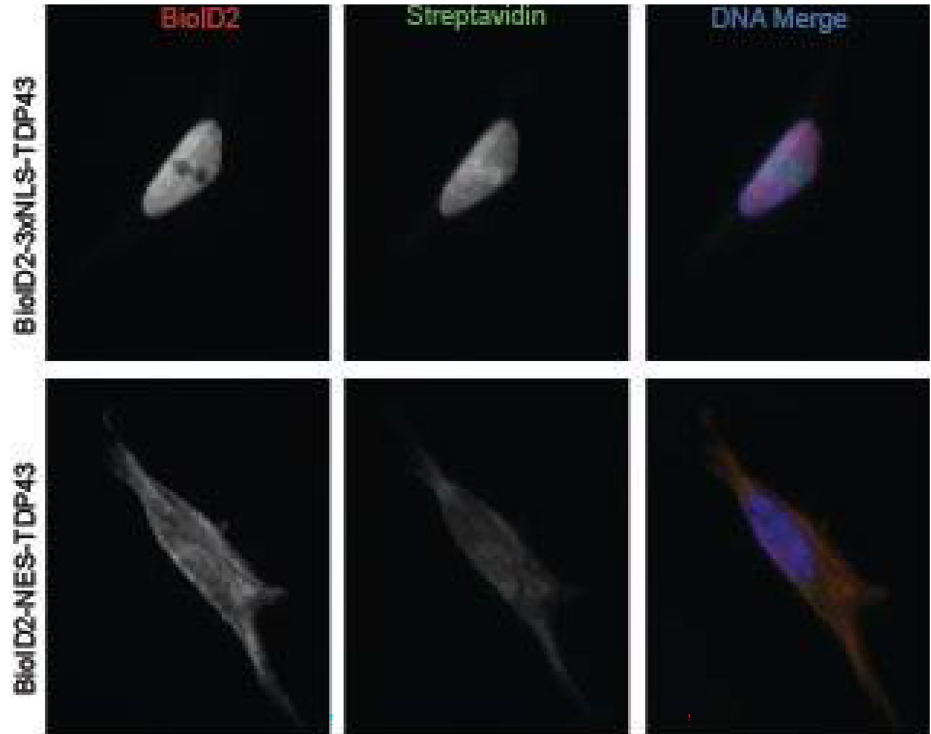
Figure 1. BioID of TDP-43 in SH-SY5Y cells in the nucleus and cytoplasm. Epifluorescence images for validating fusion-protein ( red ) expression and promiscuous biotinylation ( green ) localization following the addition of